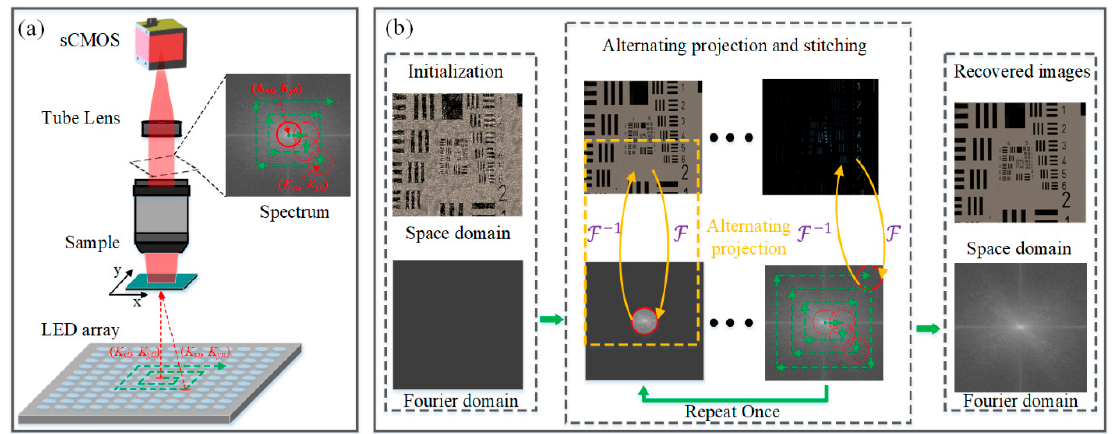
Figure 1. ( a ) Fourier ptychography microscopy (FPM) setup and ( b ) FPM algorithm